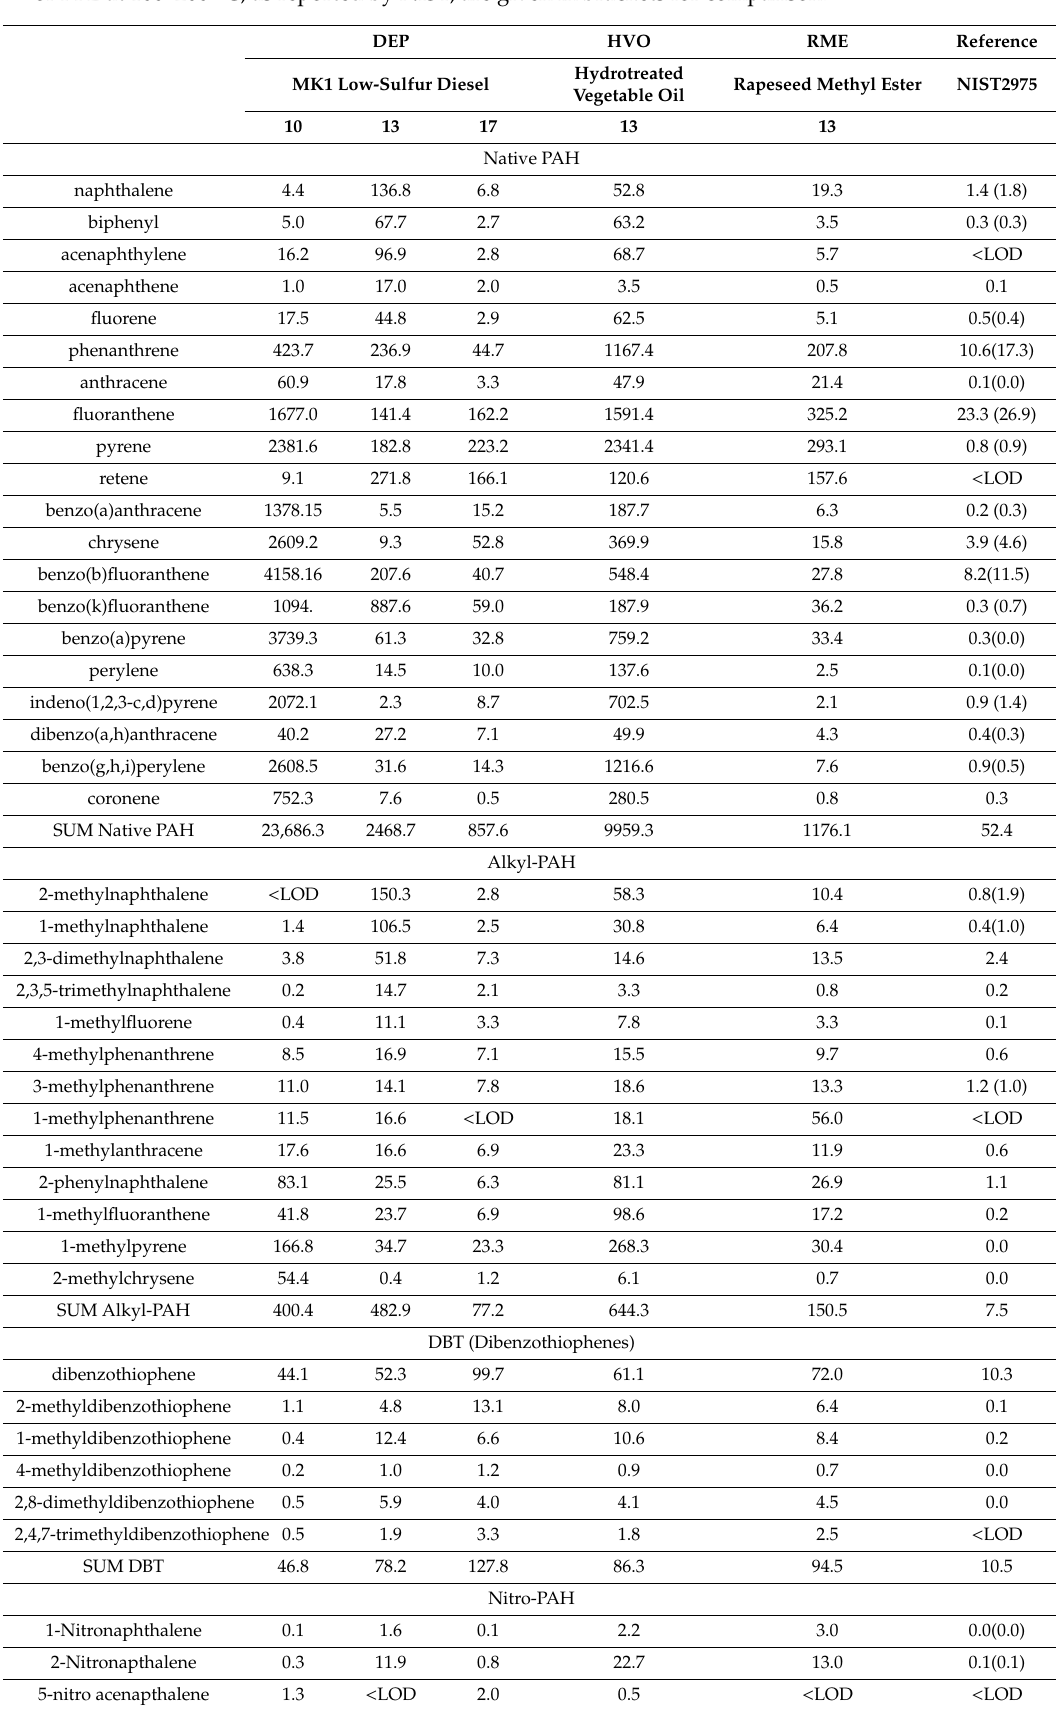
Table A4. Measured content of native PAHs and PAH derivatives in diesel emission particles and NIST2975 reference material ( µ g / g particles). PAH levels of NIST2975 quantified after soxhlet extraction or PFE at 100–200 ◦ C, as reported by NIST, are given in brackets for